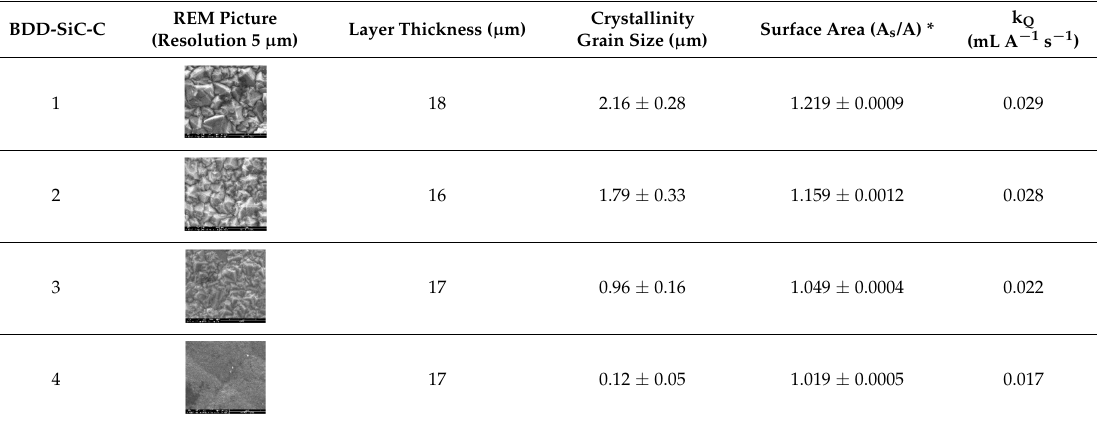
Table 2. Surface characterization of the boron-doped diamond electrode BDD-SiC-C anodes and determined reactivities; HNO 3 , pH = 1.5, κ = 17 mS cm − 1 , I = 1.0 A, stainless steel cathode. BDD-SiC-C REM Picture (Resolution 5 µm) Layer Thickness (µm)